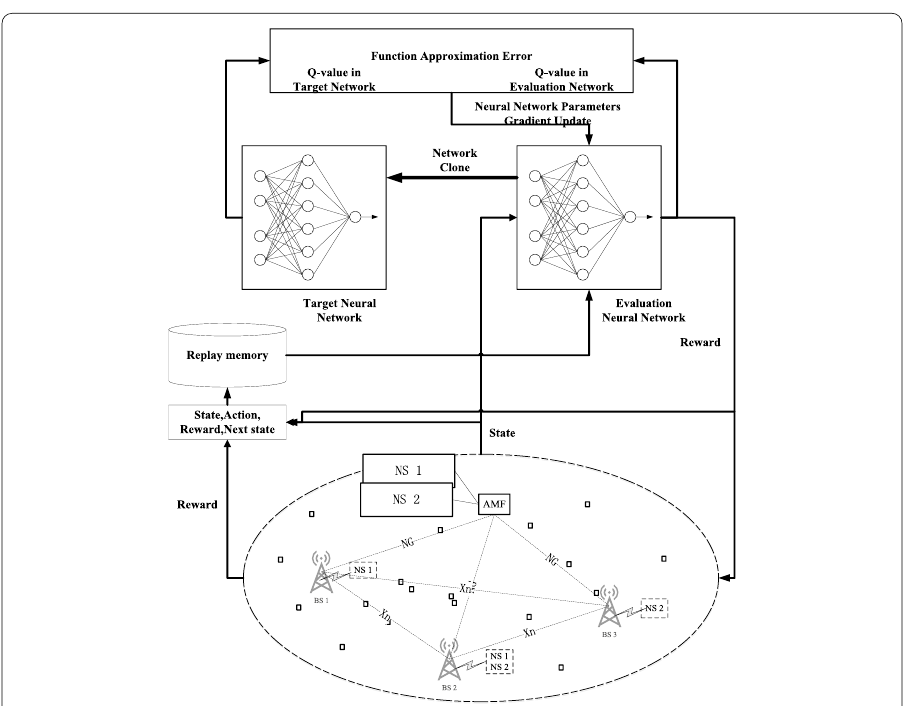
Fig. 2 Deep reinforcement learning. We design the architecture diagram of the deep reinforcement learning algorithm as shown in this figure. During the execution of the algorithm, the physical network needs